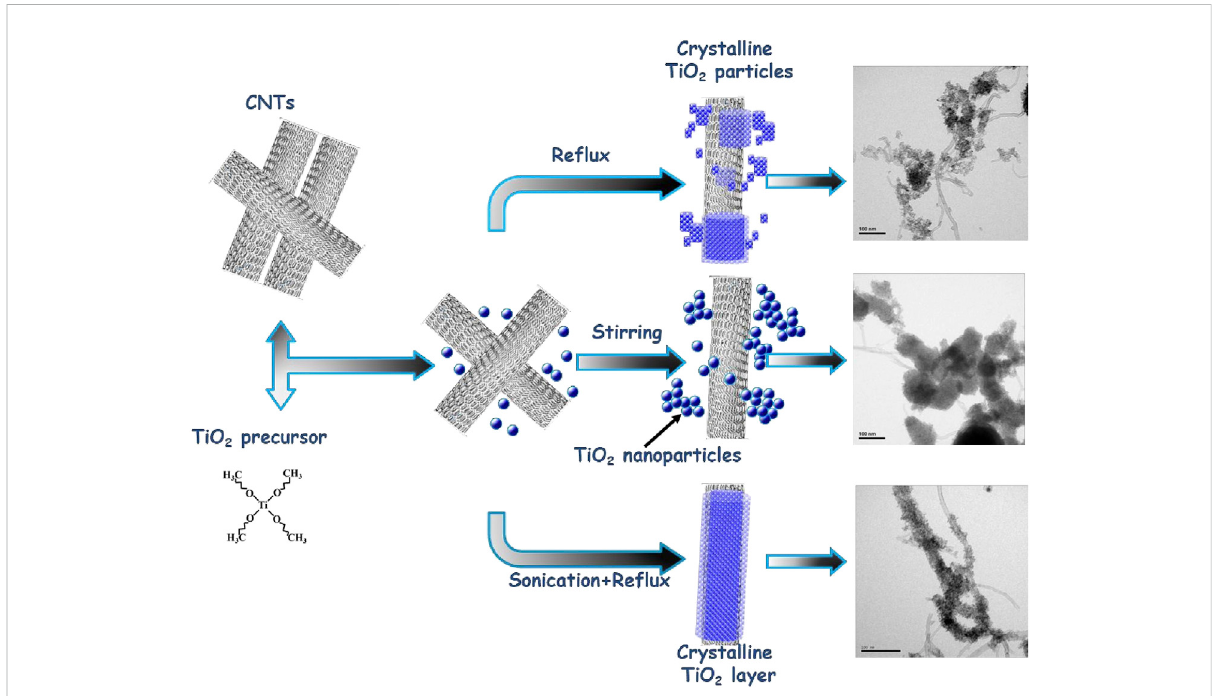
FIGURE 11 Schema of the different TiO 2 /CNT composite synthesis pathways and a TEM image of the resulting